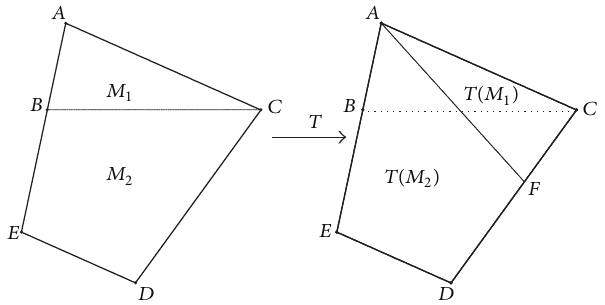
Figure 2: The piecewise isometric map (17) has two partition atoms 𝑀 𝑀 1 and 2 , and the linear parts of the restricted maps are = 𝑒 (𝜋−𝜃)𝑖 . At the same time, the map is invertible, that 𝑒 2(𝜋−𝜃)𝑖 and 𝜌 2 is, 𝑇(𝑀 1 ) ∪ 𝑇(𝑀 2 ) = 𝑀 .